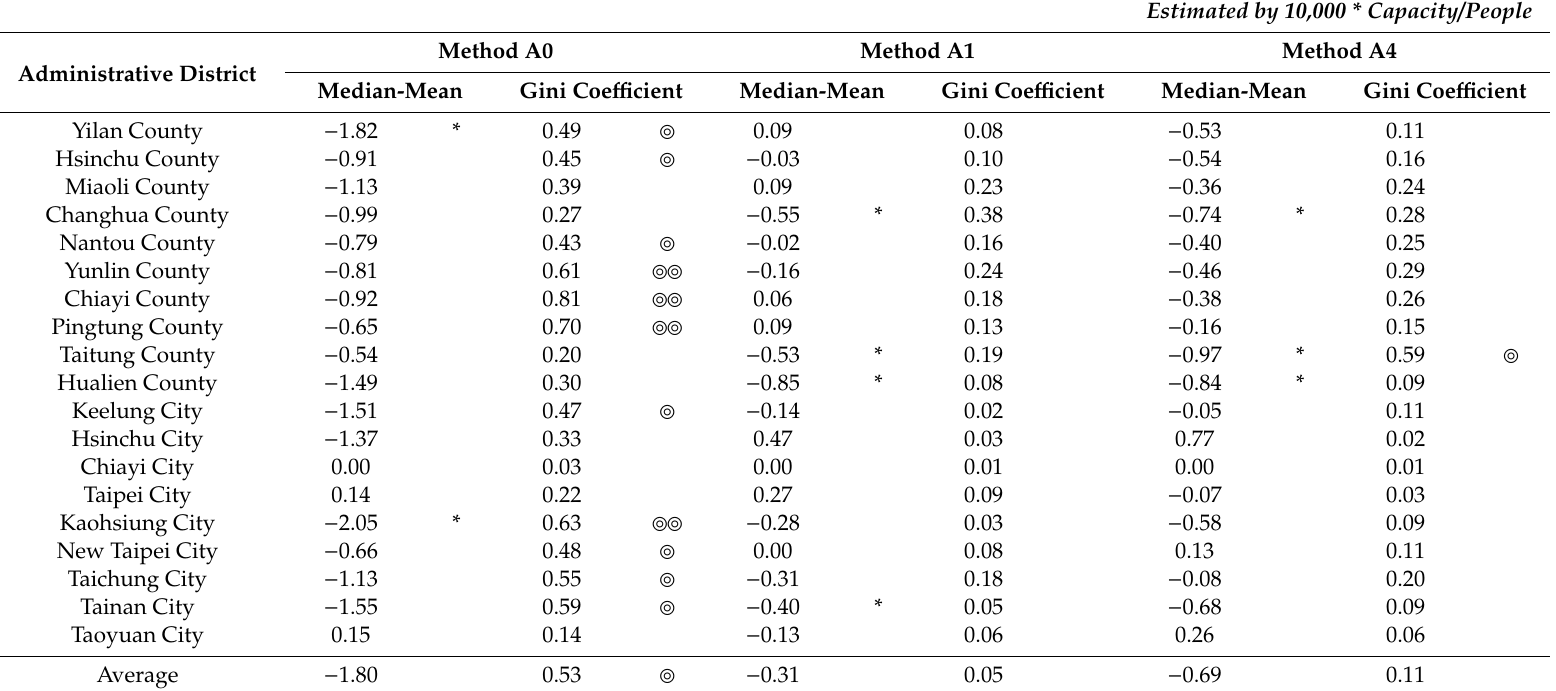
Estimated by 10,000 * Capacity /